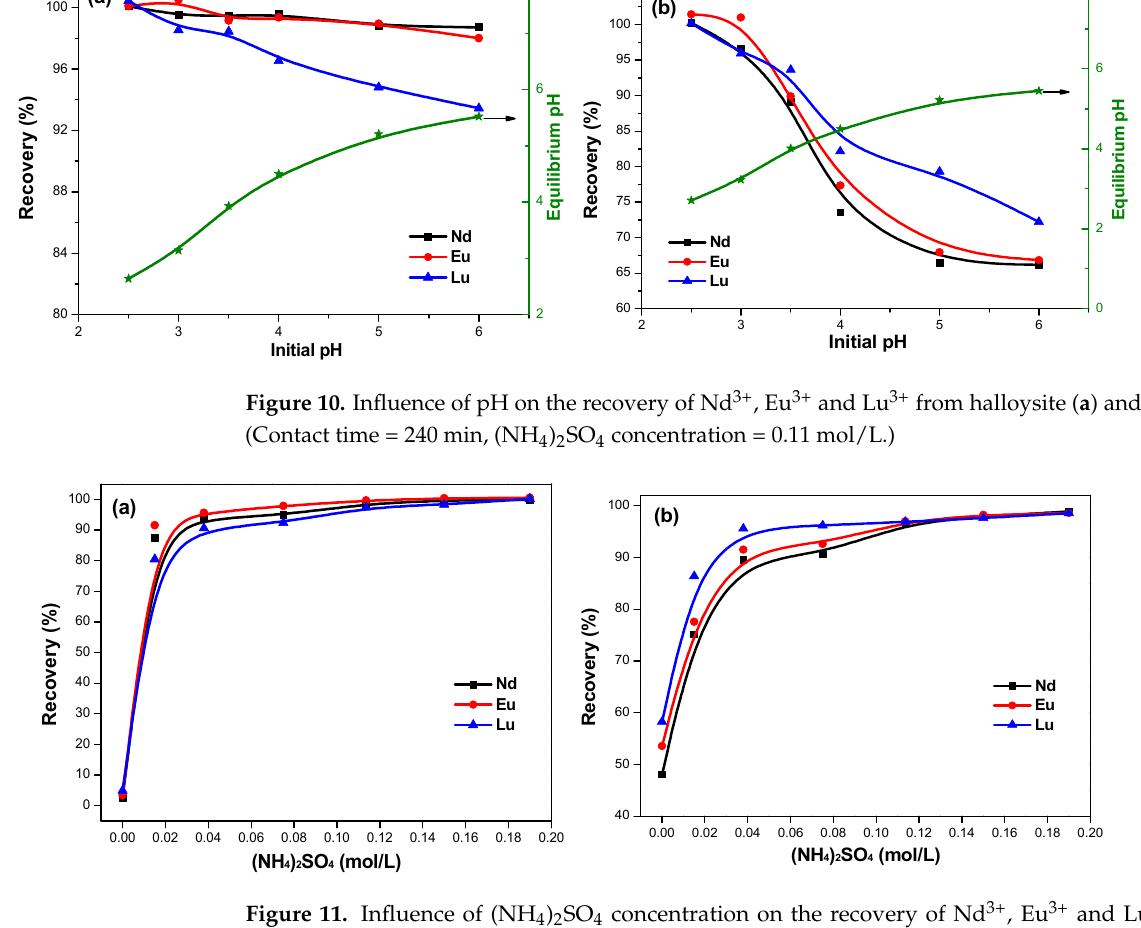
Figure 11. Influence of (NH 4 ) 2 SO 4 concentration on the recovery of Nd 3+ , Eu 3+ and Lu 3+ from halloysite ( a ) and illite ( b ). (Contact time = 240 min, pH levels for halloysite and illite are 4 and 3, respectively.)